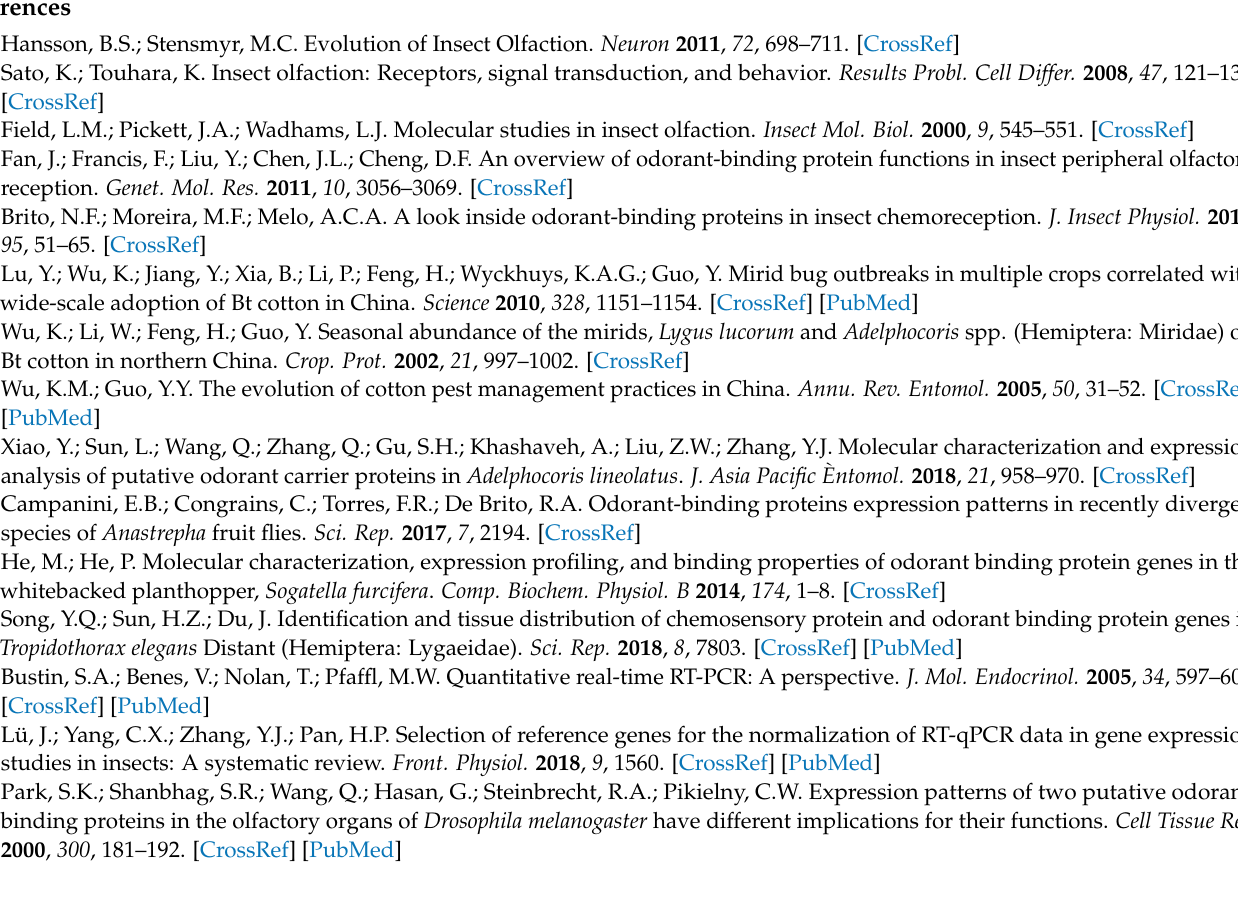
Figure S4. Fluorescence spectra of Cy5-, ROX-, FAM-PNAs with or without GO in HEPES buffer (25 mM, 100 mM NaCl, PH 7.4); Figure S5. Fluorescence spectra for PNA probes in the presence of GO (black) and incubation with chemically synthesized mRNA with scrambled sequence